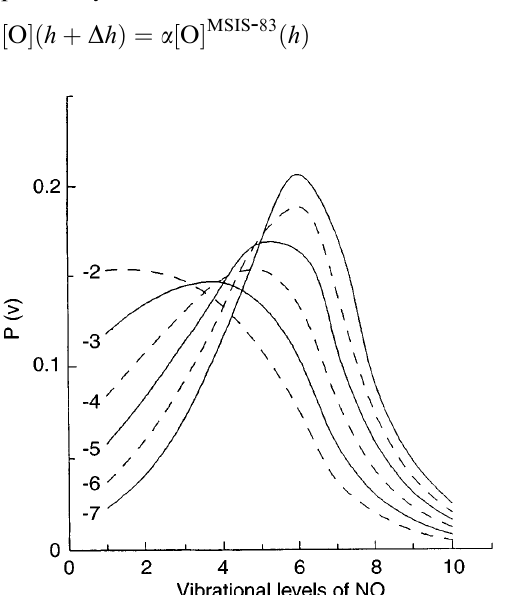
Fig. 1. The branching ratios, calculated according to surprisal theory, of the reaction (2a) for (cid:107) 1 (cid:136) ) 7–